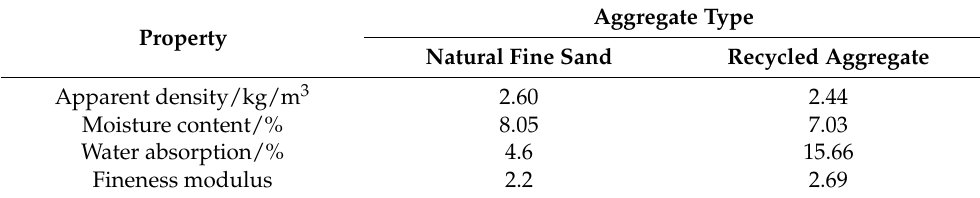
Figure 2. Particle size grading of recycled aggregate. Table 1. Physical properties of the natural fine sand and recycled aggregate.